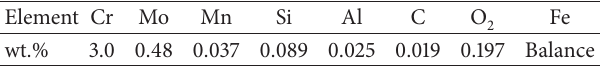
Table 1: Chemical composition of AstCrM powder used.